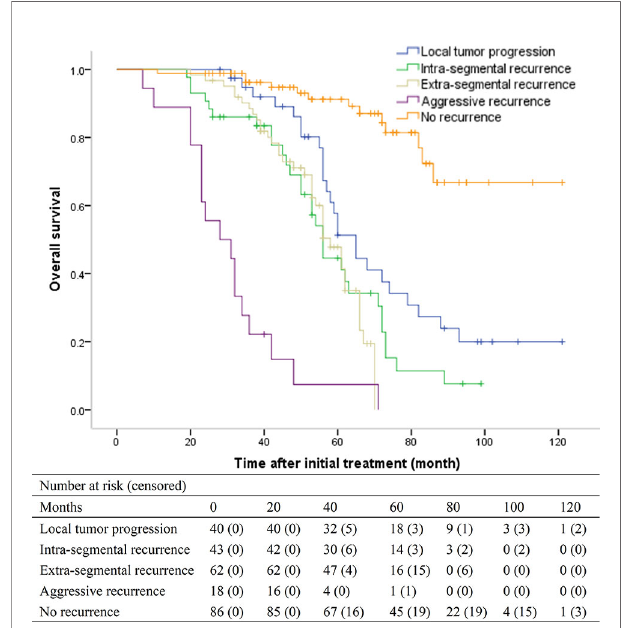
FIGURE 3 | Kaplan-Meier curves of overall survival (OS) in patients with local tumor progression (median, 65 months), intra-segmental recurrence (median, 56 months), extra-segmental recurrence (median, 58 months), aggressive recurrence (median, 28 months), and no recurrence (median, > 86 months), respectively (overall P